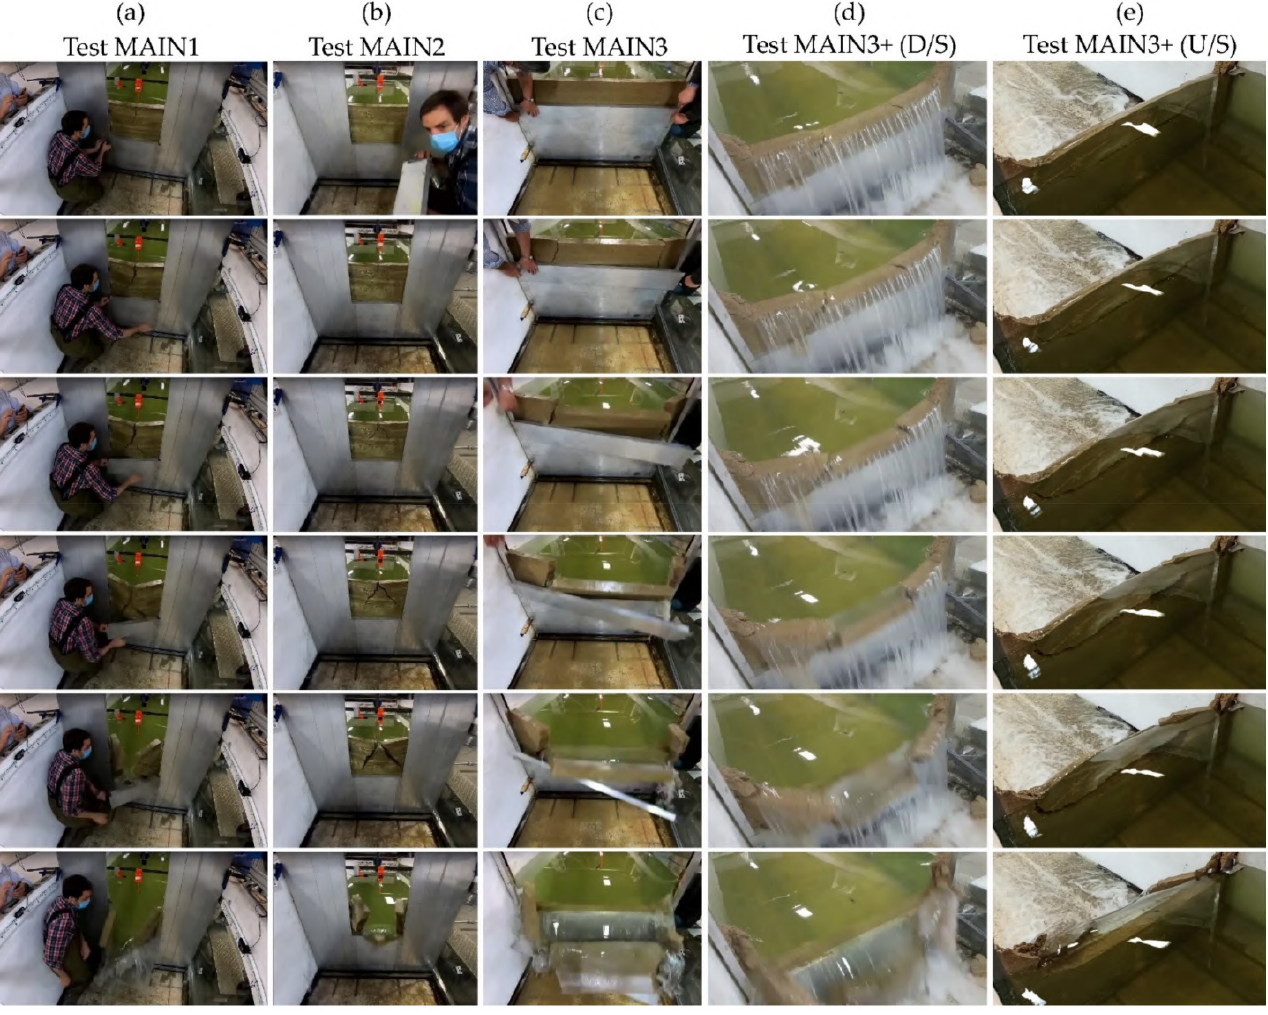
Figure 11. Sequential images of the failures of the Main Laboratory Experiments. ( a ) Test MAIN1; ( b ) Test MAIN2; ( c ) Test MAIN3; ( d ) Extra test MAIN3+ from the downstream side; ( e ) Extra test MAIN3+ from the upstream